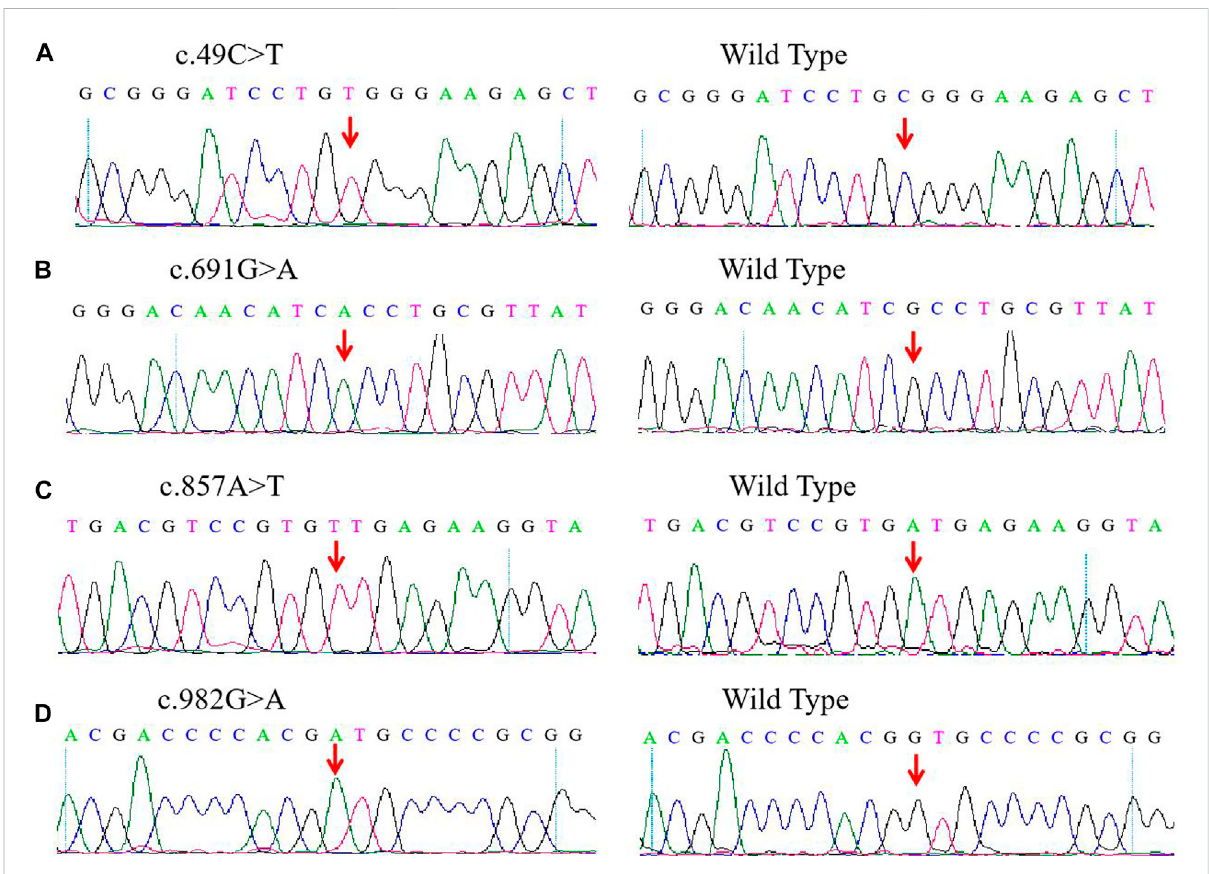
FIGURE 1 Detection of four novel G6PD variations by Sanger sequencing. (A) c.DNA 49C > T site in exon 2. (B) c.DNA 691G > A site in exon 7. (C) c.DNA 857A > T site in exon 8. (D) c.DNA 982G > A site in exon 9. The red arrow indicates the location of the